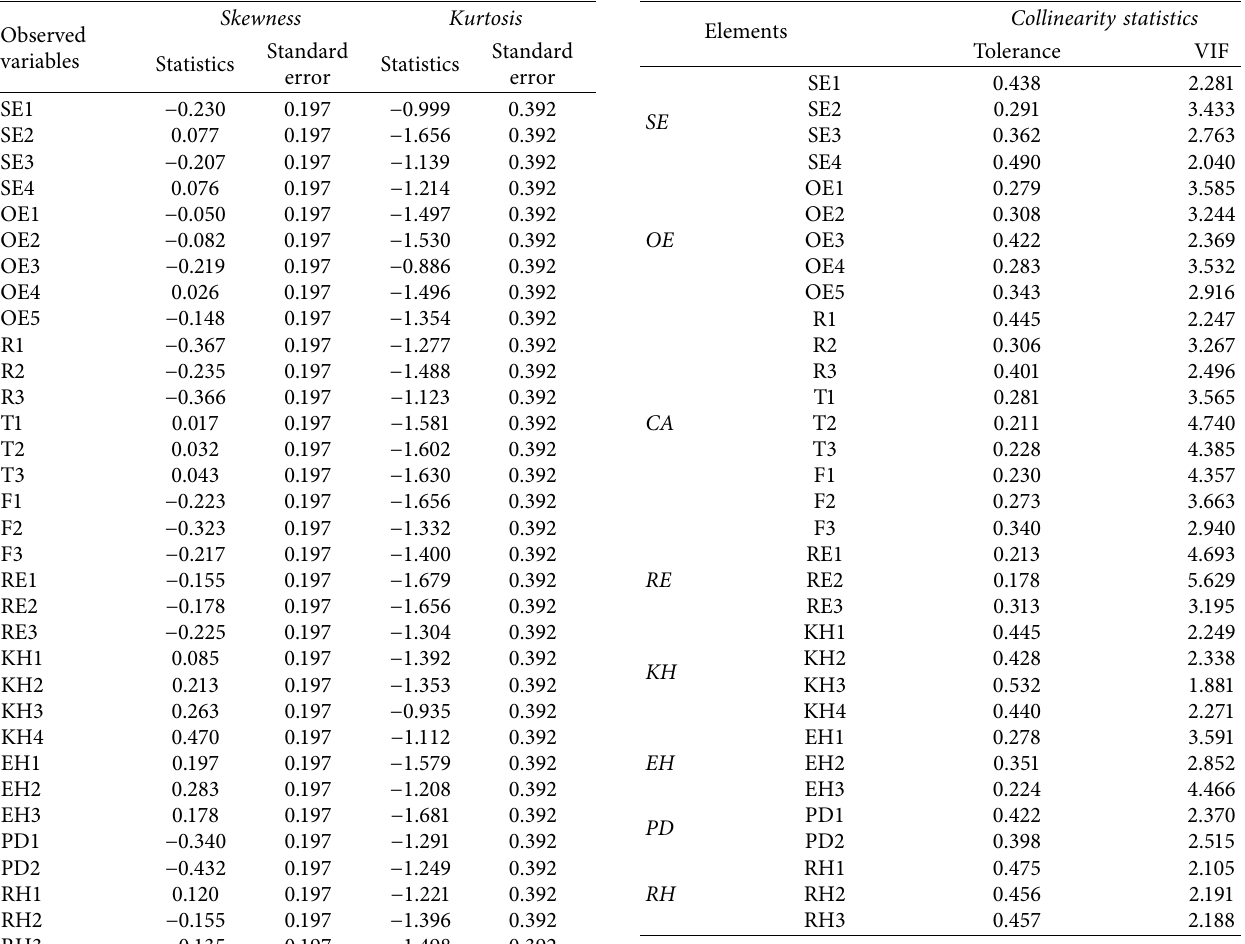
Table 9: Multicollinearity test results. Table 8: Normality test of observed